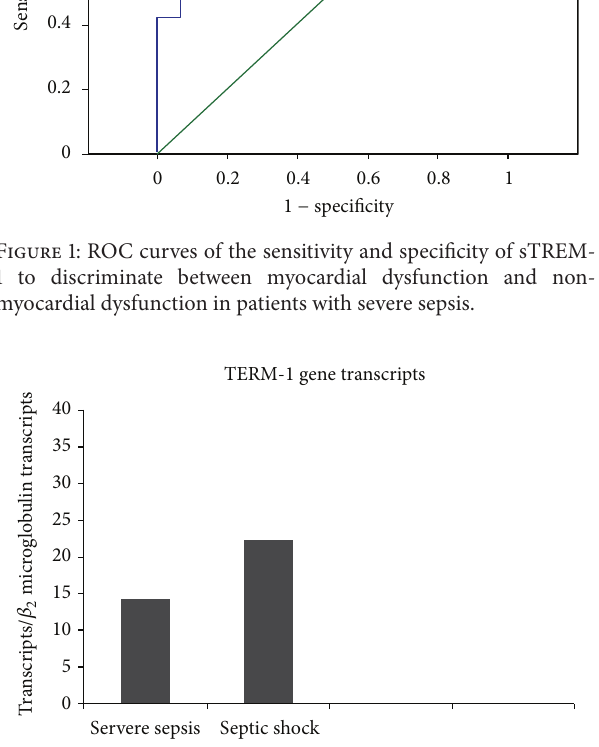
Figure 2: Gene transcripts of TREM-1 in Separated peripheral blood mononuclear cells (PBMCs) isolated from 40 patients with severe sepsis and from 45 patients with septic shock. 𝑃 > 0.05 between severe sepsis group and septic shock